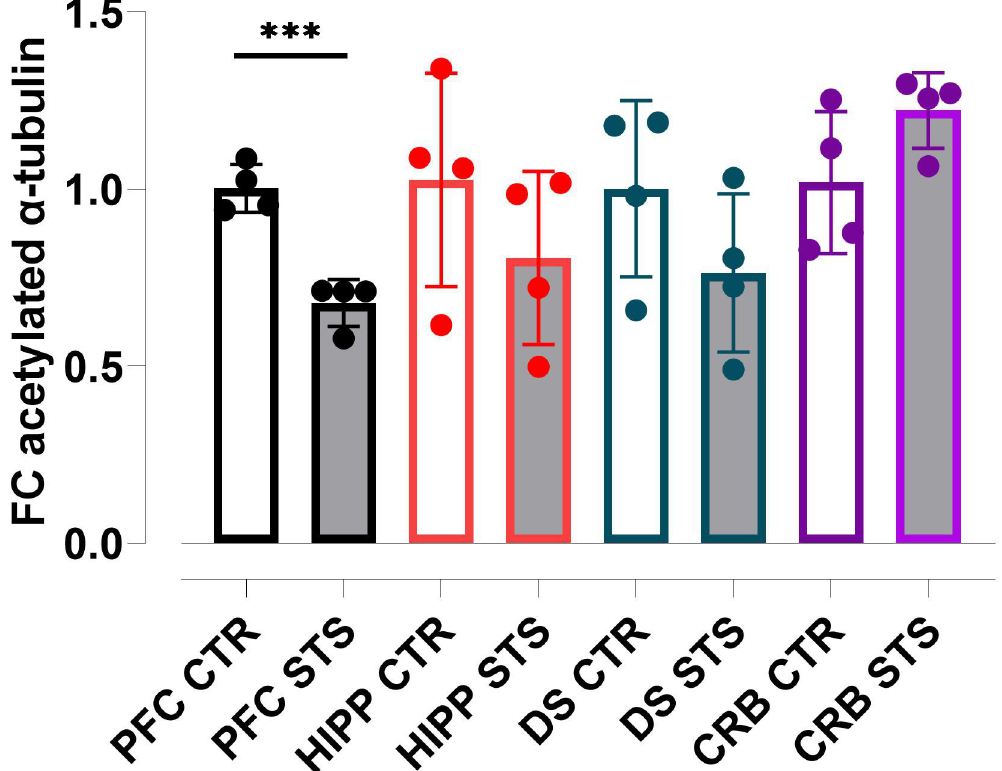
Fig 1. Psychosocial stress affects α -tubulin acetylation at K40 in different brain regions. Individual brain regions of control and stressed animals exposed to V+V were dissected and protein lysates prepared. Four biological replicates each were loaded onto SDS-gels, blotted, and finally tested with antibodies against acetylated- α -tubulin (K40) and β -actin. The relative amount of acetylated- α -tubulin in each lane was calculated by normalization for β -actin in the same lane. The fold changes of the relative amount of acetylated- α -tubulin in distinct brain regions of stressed animals were calculated using the mean value of the relative amount of acetylated- α -tubulin in the same brain region of control animals as reference. The dots represent the average values of the relative amount of acetylated- α -tubulin of all technical replicates for each of the four biological replicates. Light grey bars represent the stress group. CTR, control; STS, stress; V, vehicle; PFC, prefrontal cortex; HIPP, hippocampus; DS, dorsal striatum; CRB, cerebellum. One, two or three symbols indicate p < 0.05; p < 0.01, p < 0.001, respectively.